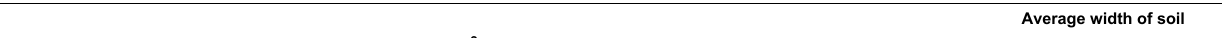
Table 2. Physical properties of soil under SUI and FLI (CK1) †